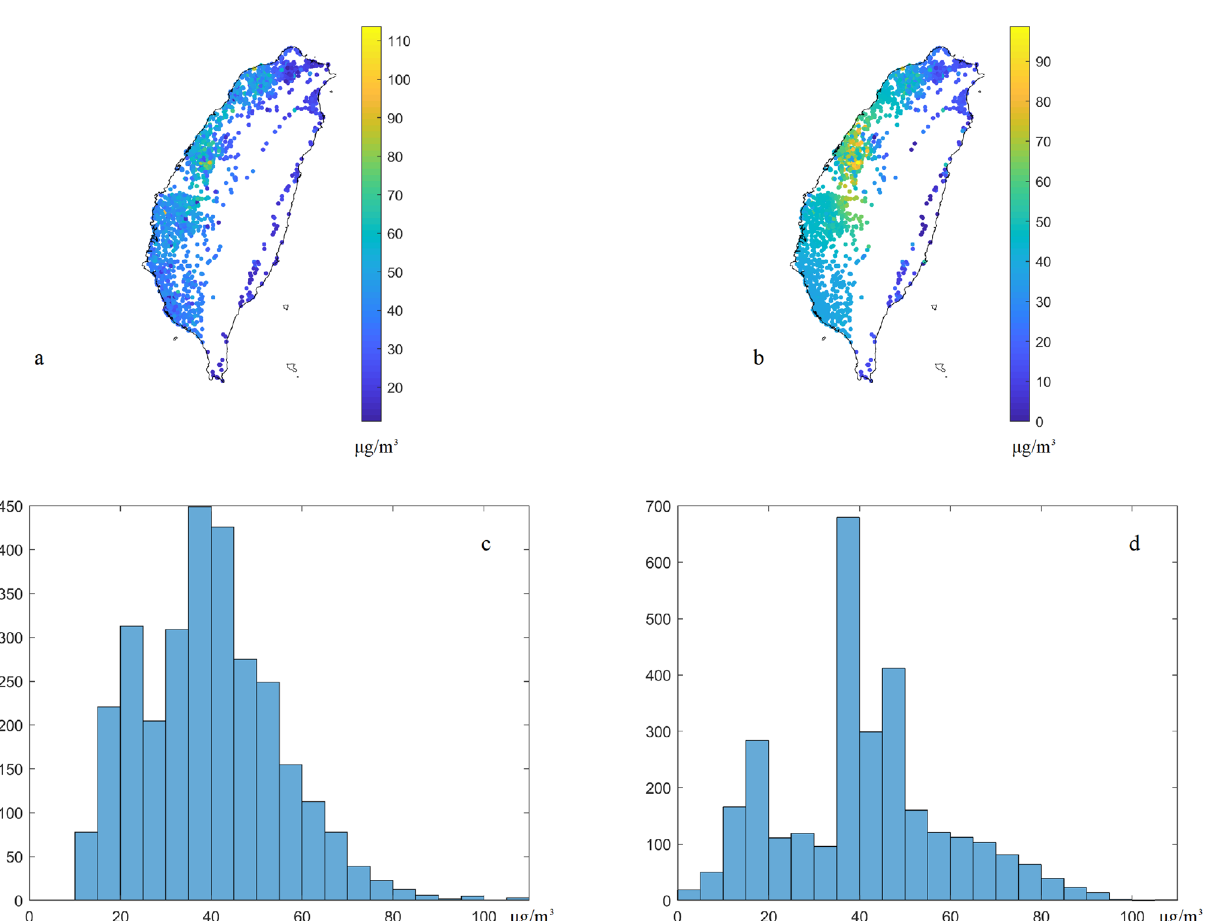
Figure 5. Spatial patterns of calibrated PM 2.5 based on the ( a ) nonspatial and ( b ) spatial calibration models, and the data distribution of calibrated PM 2.5 from the ( c ) nonspatial and ( d ) spatial calibration models. The plots were created in MATLAB_R2018B (https ://www.mathw orks.com/produ cts/matla